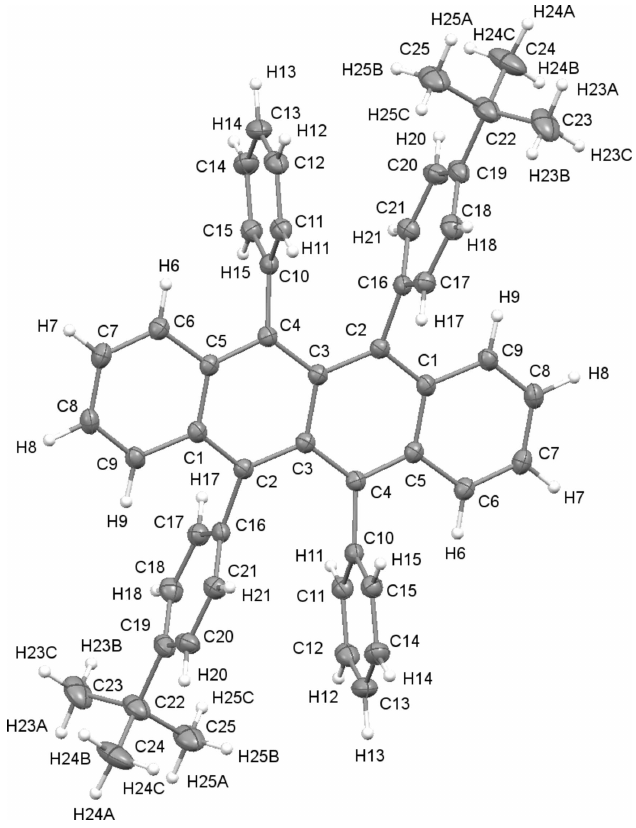
Figure 2 Crystal structure of 2 with displacement ellipsoids shown at the 50% probability level.